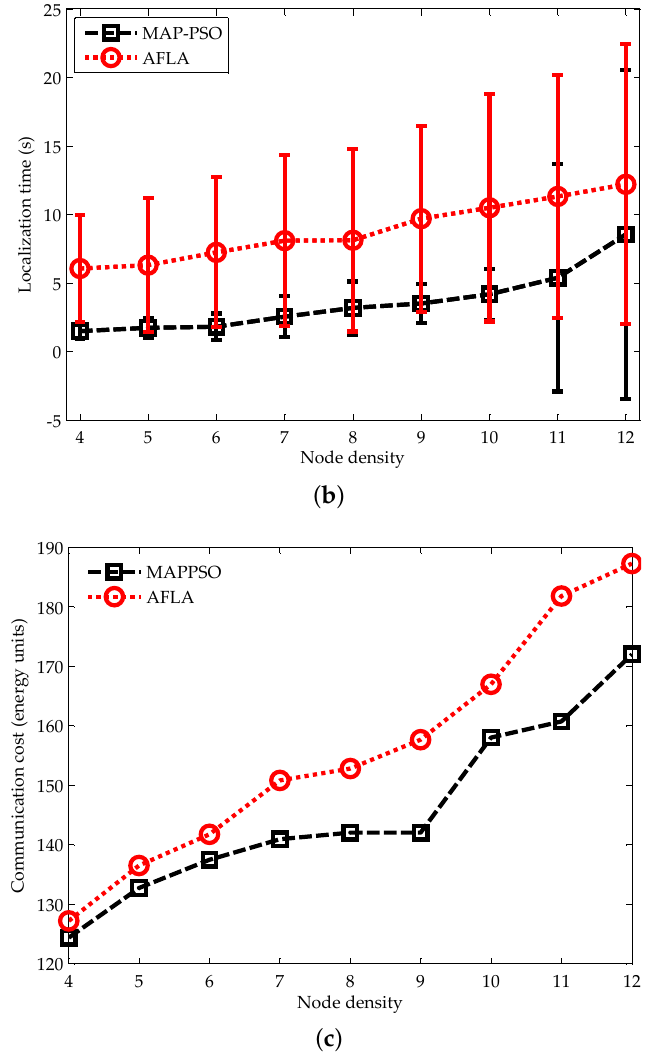
Figure 9. Impacts of the node density on: ( a ) localization accuracy; ( b ) localization time; ( c ) communication